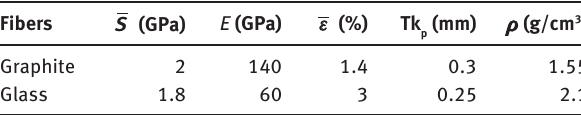
Table 1 Properties of unidirectional epoxy composites.